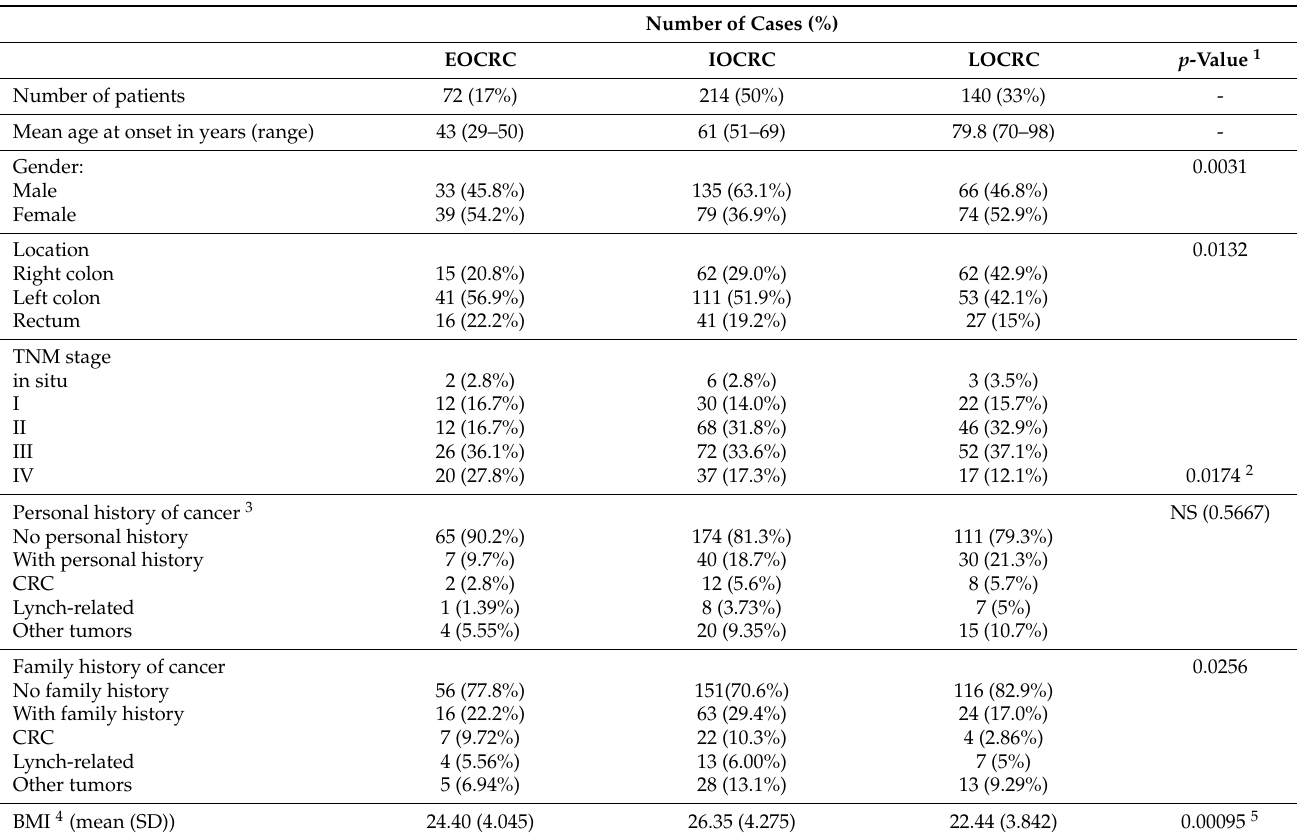
Table 1. Clinical, pathological, and familial features of the